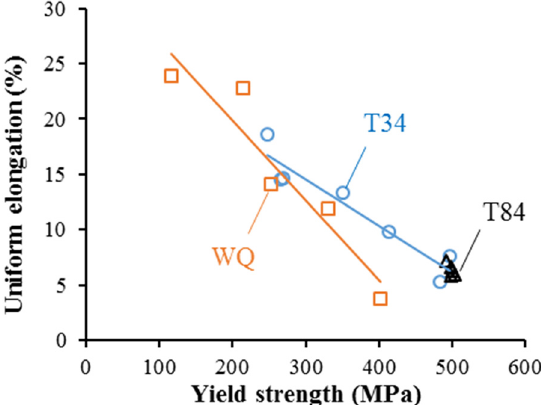
Fig. 7. Relationship between uniform elongation and yield strength for the creep-aged AA2050 alloys with WQ, T34 and T84